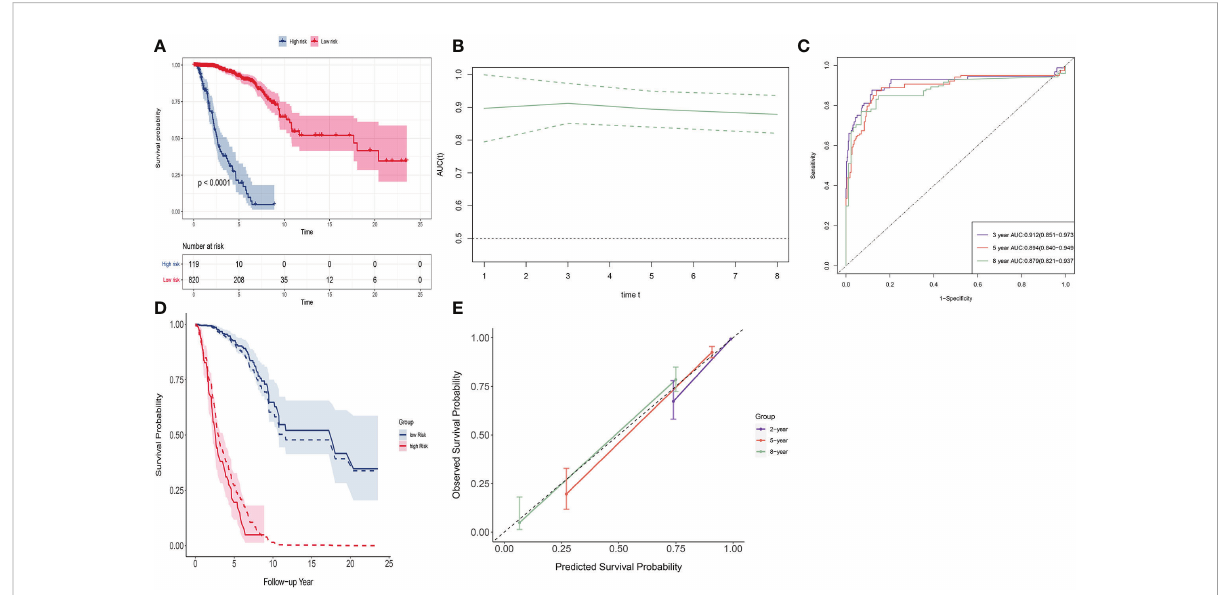
FIGURE 3 Discrimination and calibration of SNV signature in BRCA data. (A) The K-M curve of the low-risk group and the high-risk group. (B) Time- dependent AUC of SNV signature. (C) The 2-, 5-, and 8-year AUC of SNV signature. (D) The observed survival curves (solid line) and predicted survival curves (dotted line). (E) Calibration plot for 2-, 5-, and 8-year AUC of SNV